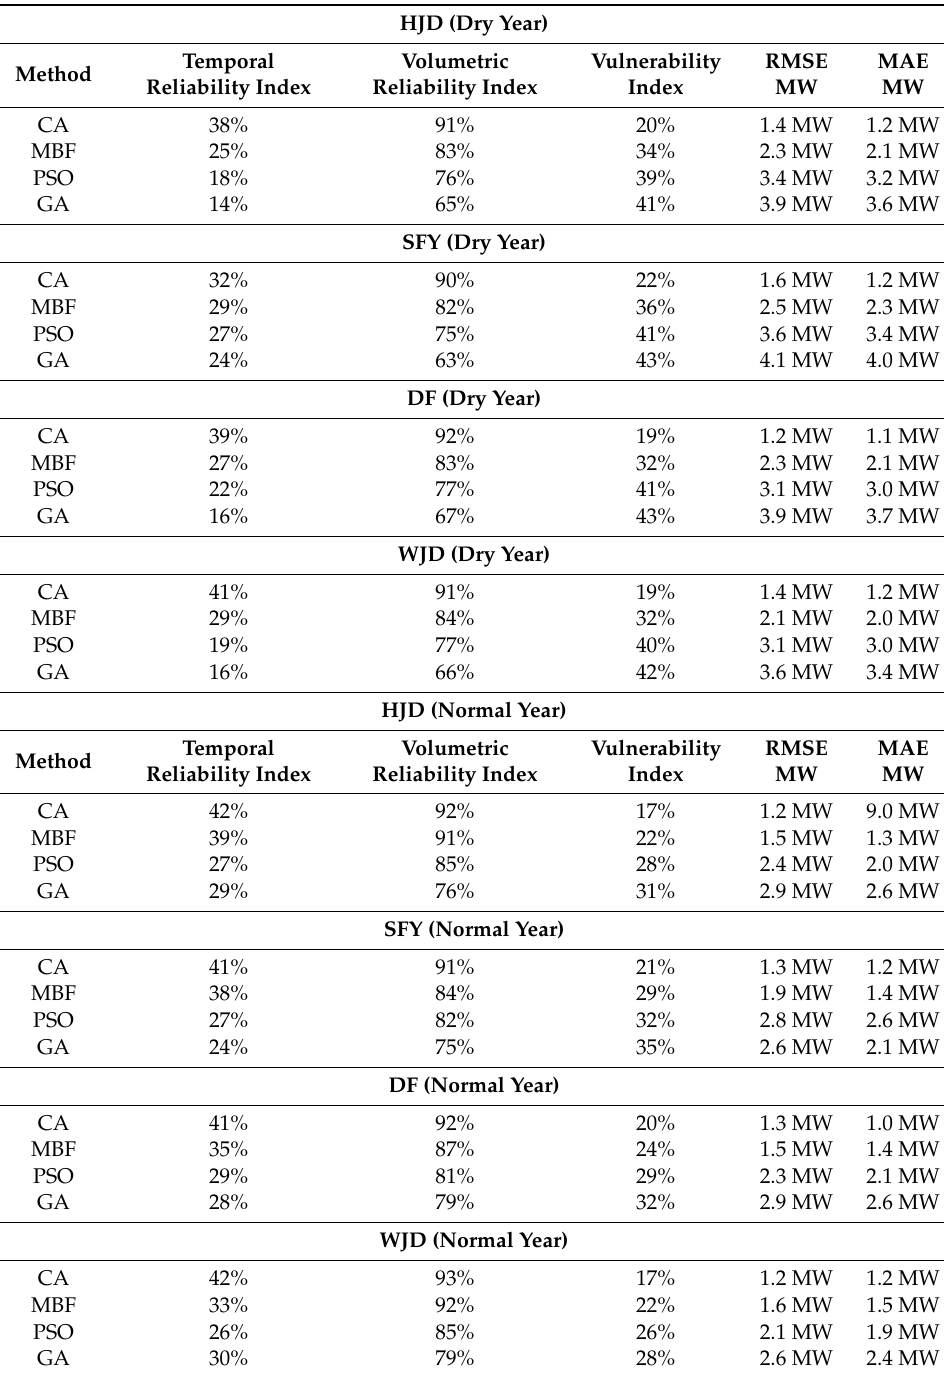
Table 5. Computed indexes for generated power for dry years, normal years, and wet years. RMSE: Root mean square error; MAE: Mean absolute